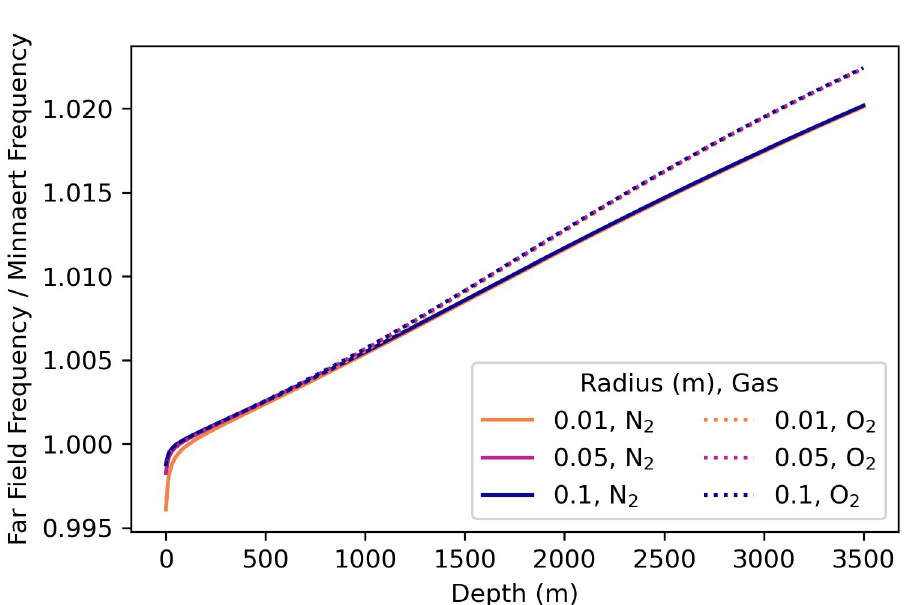
Fig 3. Ratio of far-field resonant frequency to Minnaert frequency vs. depth. The ratio of the far-field resonance frequency f σ to the Minnaert frequency f M vs. depth calculated for nitrogen and oxygen bubbles of radii 0.01 m, 0.05 m, and 0.10 m for a 1.5˚C constant temperature, 35.0 g/kg constant salinity depth profile. Water and gas parameter values were calculated at 1 m depth intervals and interpolated between these depths. See section 7 in S3 and S4 Files for the calculations used for this plot. ffiffiffiffiffiffiffiffiffi p oscillation, o ¼ k = m und